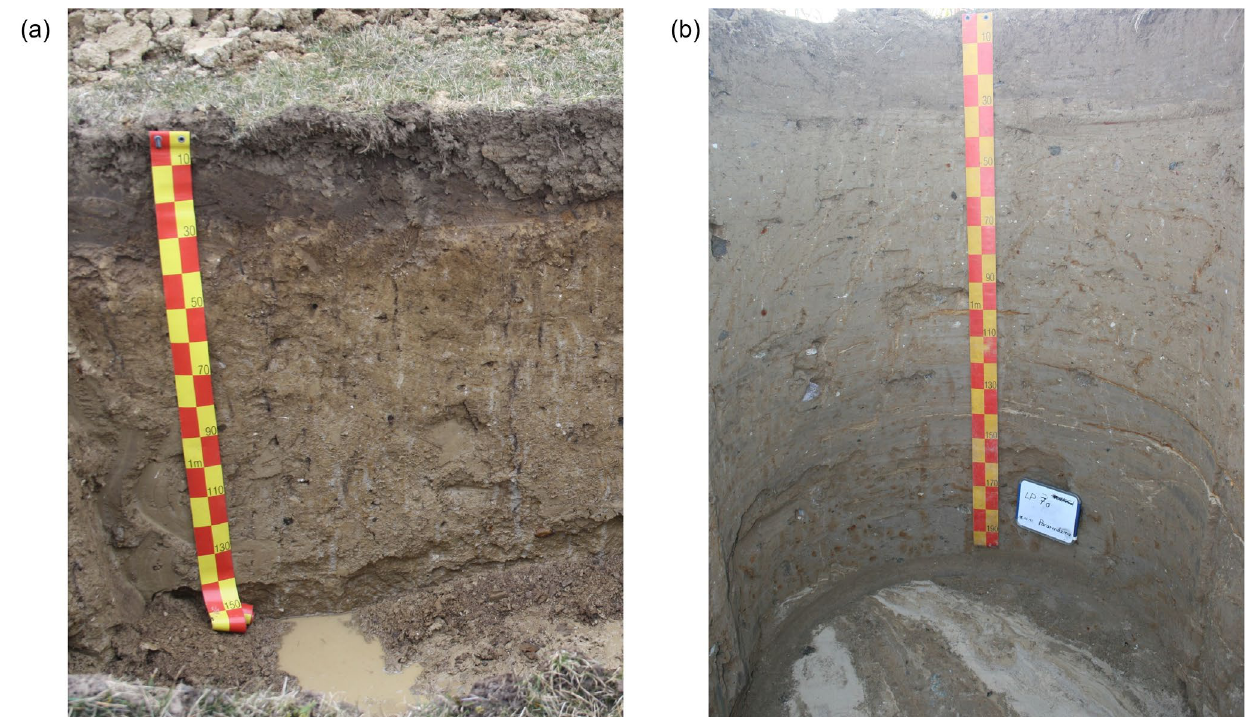
Figure A3. Earthworm activity in the ( a ) Luvisol and the ( b ) Regsol. Earthworm burrows can be identified by the black coating.